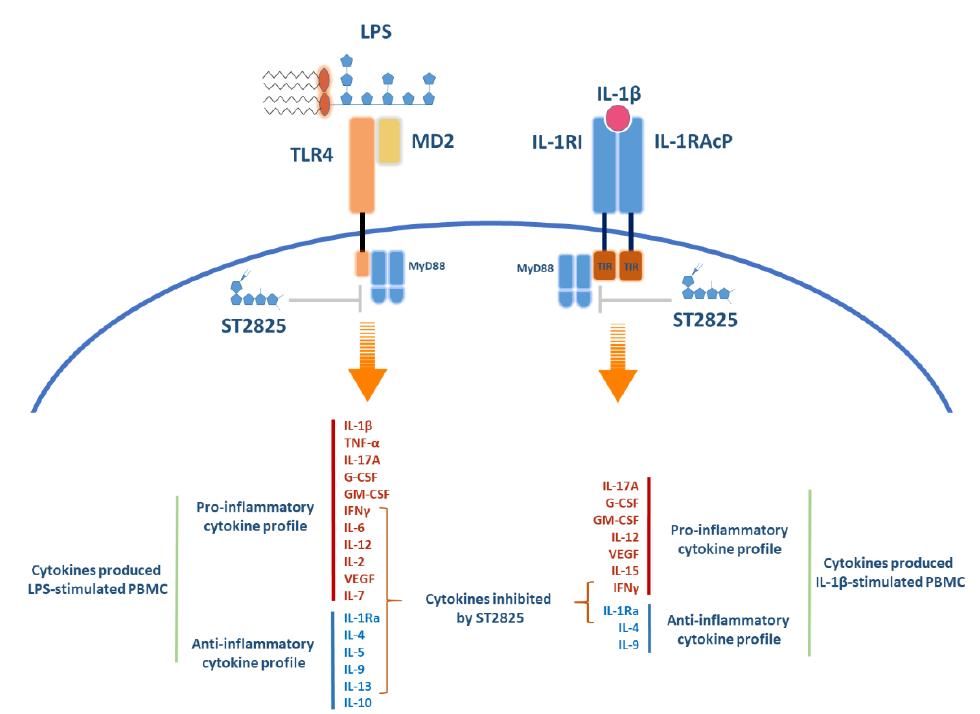
Figure 4. Schematic outline of cytokine release from rhIL-1 β and LPS-stimulated PBMC, and cytokine inhibition orchestrated by the e ff ect of ST2825. For illustrative purposes, we performed a representative figure to summarise our results. On the left side of this illustration, inflammatory cytokine release from LPS-stimulated PBMC is presented. On the right side of the illustration, inflammatory cytokine release from rhIL-1 β -stimulated PBMC is presented. For both cases, the pro- and anti-inflammatory cytokine profiles are indicated in red and blue, respectively. The cytokines inhibited by e ff ect of ST2825 are indicated with curly braces. LPS, lipopolysaccharide; TLR, toll-like receptor 4; MD2, myeloid di ff erentiation factor 2; IL-1 β , interleukin-1 beta; IL-1RI, IL-1 receptor type I; IL-1RAcP, interleukin1receptoraccessoryprotein. TIR,toll-IL-1-receptordomains; MyD88, myeloiddi ff erentiation primary response 88. ST2825, MyD88 dimerisation